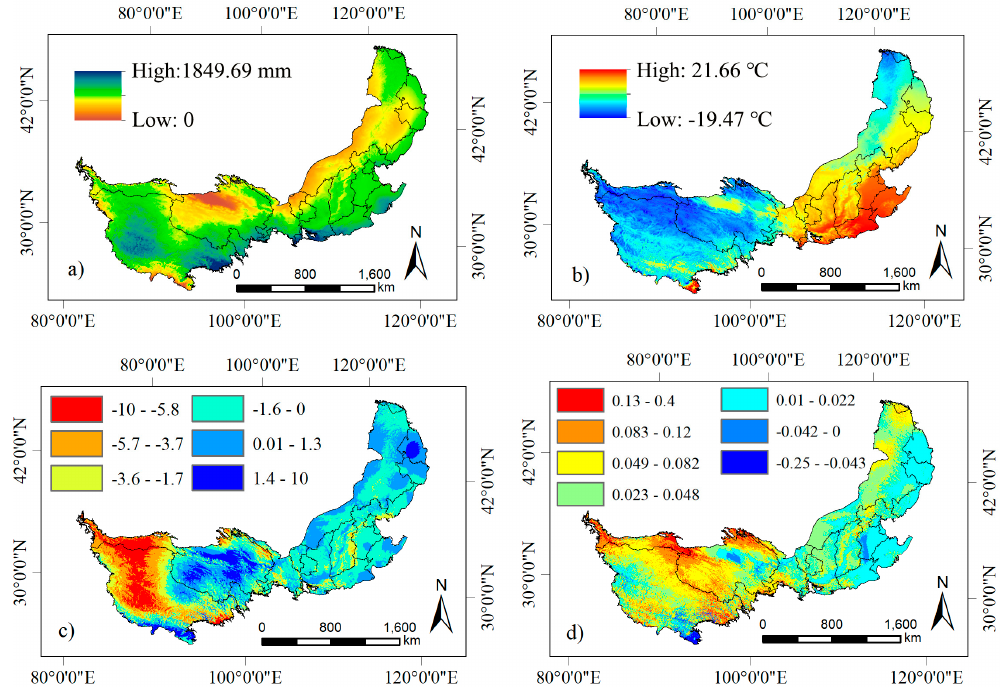
Figure 2. The spatial pattern and variation trend of average annual precipitation and temperature from 1951 to 2015 ( a ): Precipitation, ( b ): Temperature, ( c ): Precipitation variation trend; ( d ): Temperature variation trend.